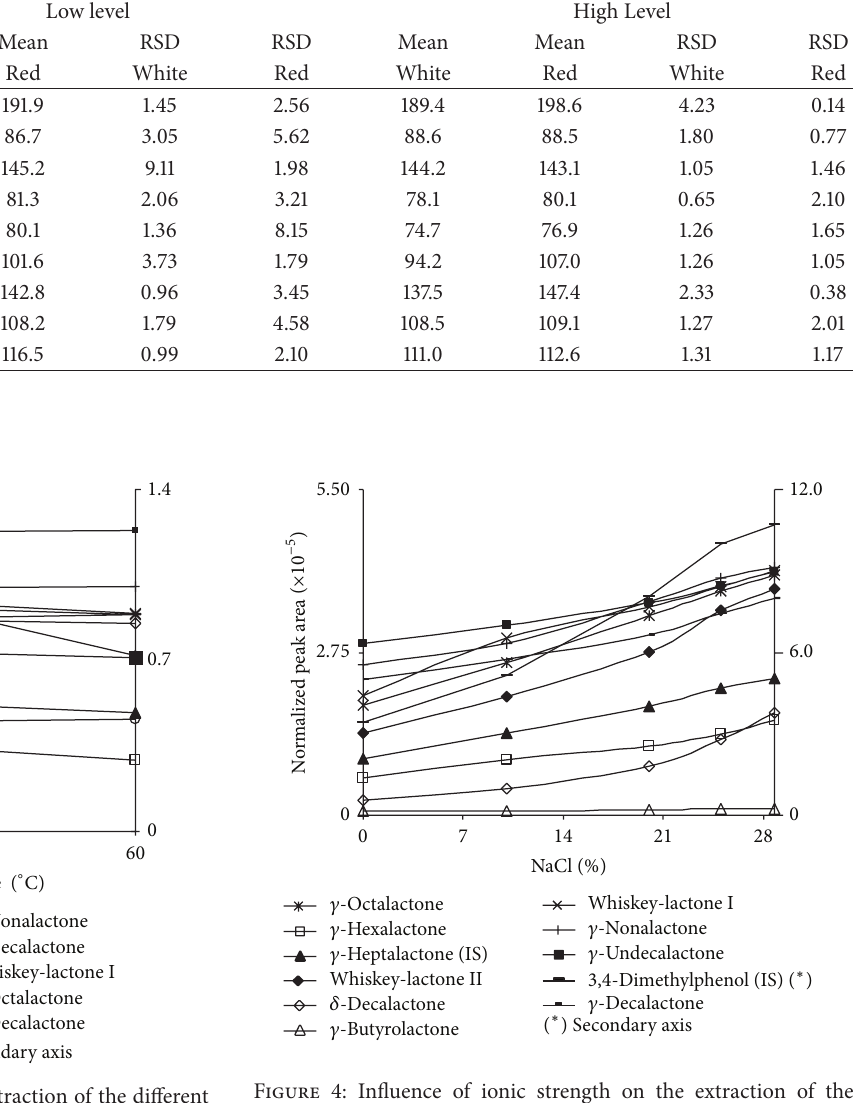
Figure 3: Temperature influence on the extraction of the different analytes on a PA fiber. Table 8: Mean of recoveries and RSD.